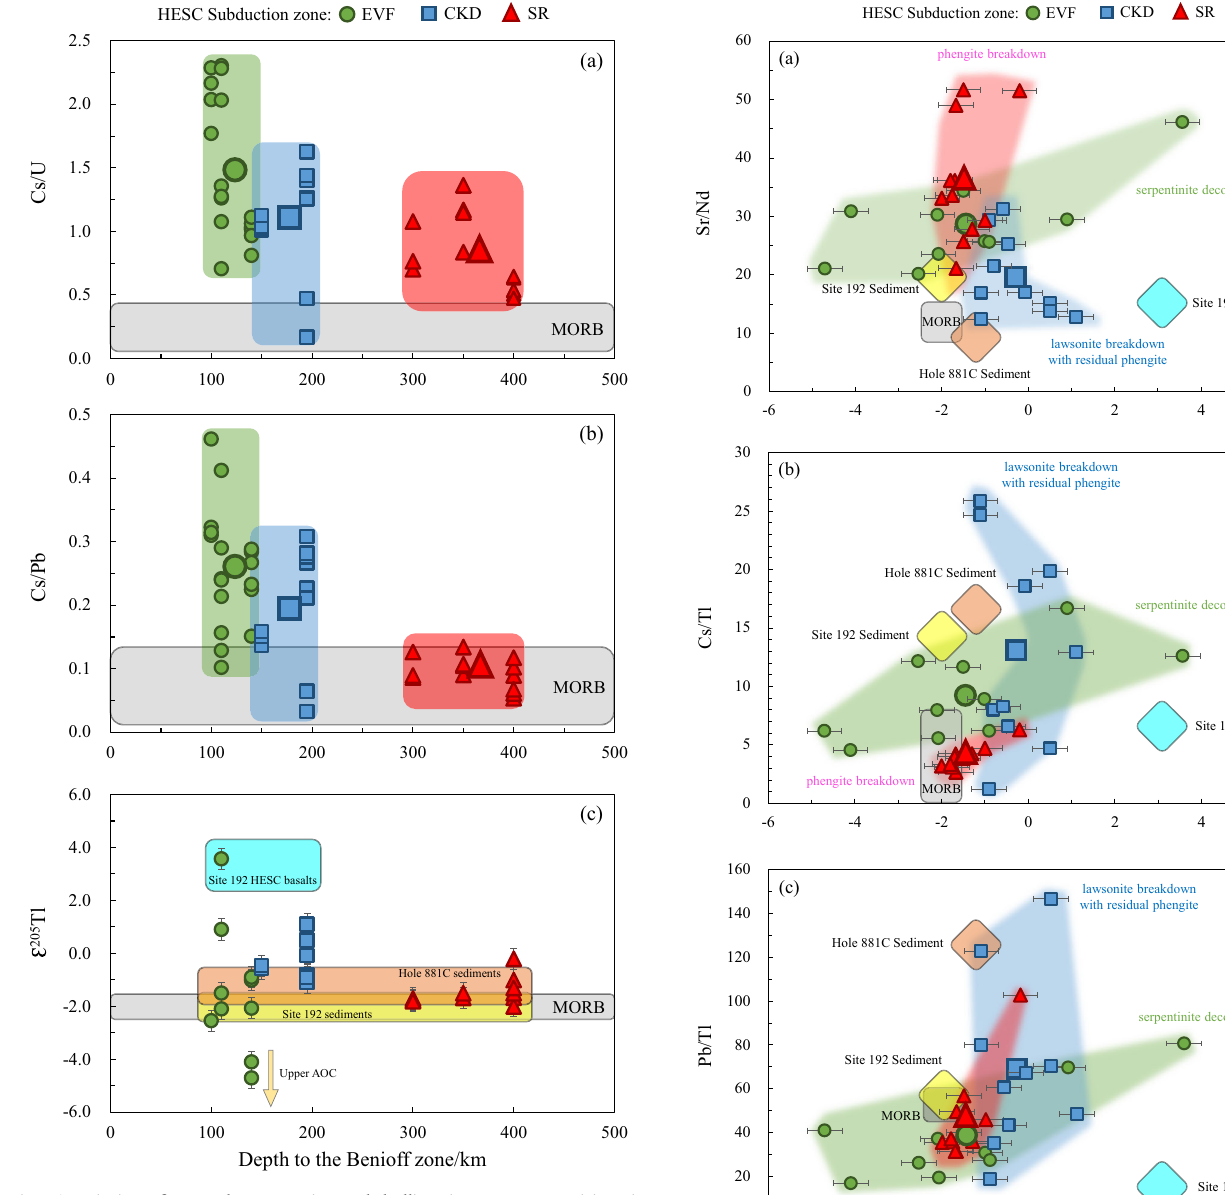
Fig. 6 | Variation of trace element ratios and thallium isotope compositions in Kamchatka arc lavas within the zone of Hawaii-Emperor Seamount Chain (HESC)subductionalongslabdepth.a Cs/U,( b )Cs/Pband( c ) Ɛ 205 Tlvaluesversus depth to the Benioff zone. The depth to the Benioff zone is from ref. 38. The Kamchatkalavasin( a )and( b )havebeen fi lteredfordeepocean-island-basalt(OIB) componentsforIchinskyvolcano.TheTlisotopecompositionsofKamchatkalavas in( c )havebeen fi lteredfordegassinganddeepOIBcomponents(seediscussionfor